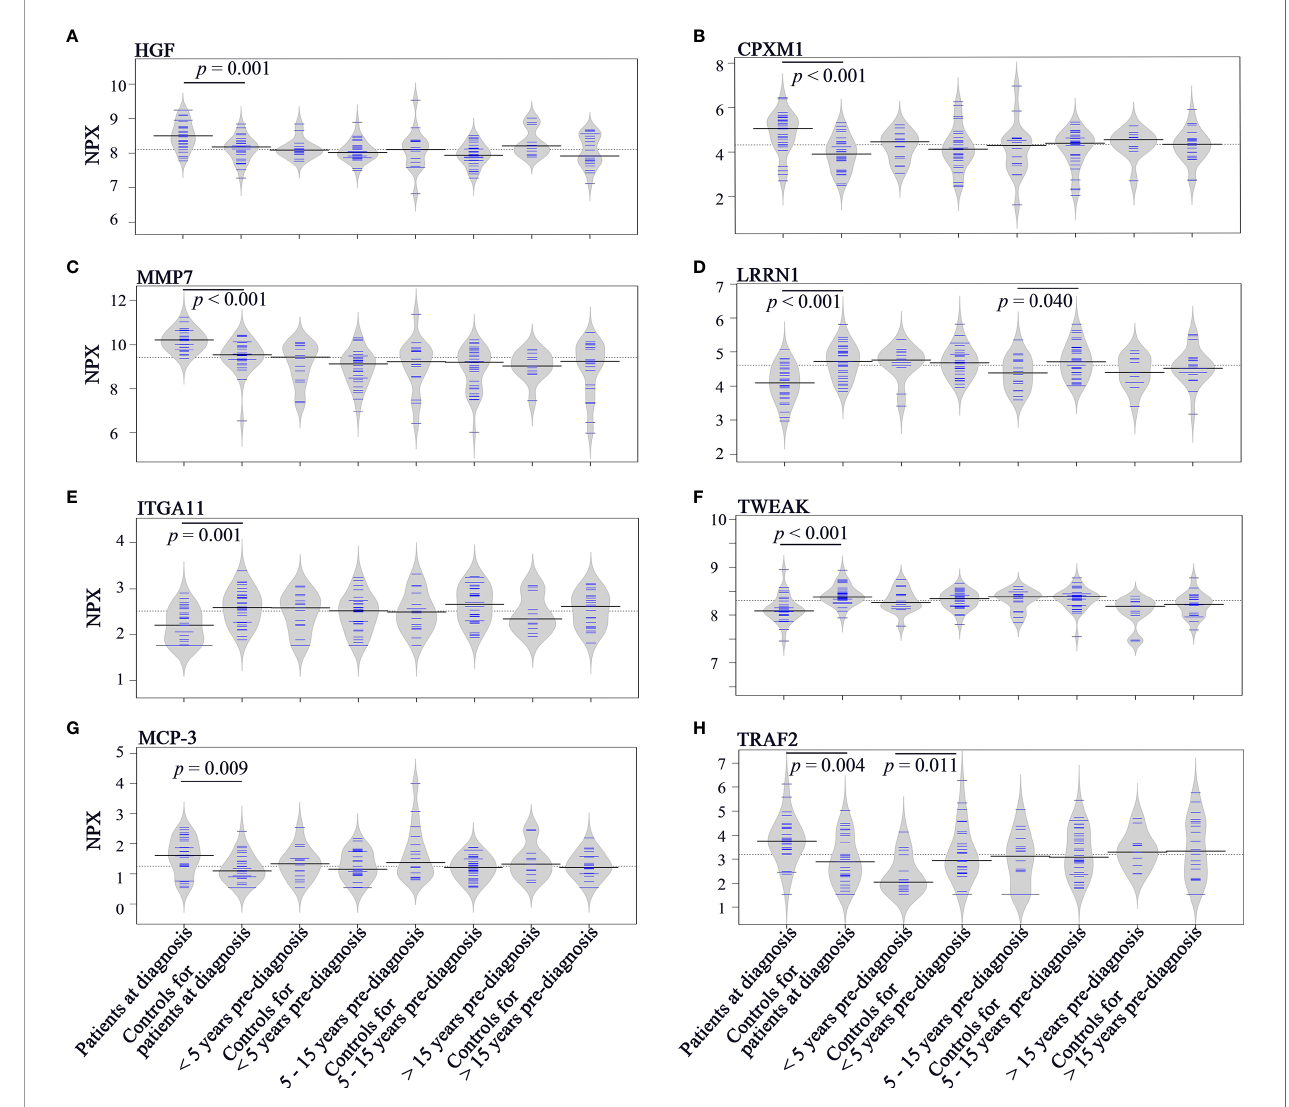
FIGURE 4 | Bean plots showing protein levels in different groups of plasma samples. (A) HGF. (B) CPXM1. (C) MMP7. (D) LRRN1. (E) ITGA11. (F) TWEAK. (G) MCP-3. (H) TRAF2. The grey area shows the estimated density of distribution. The horizontal lines within the grey area show individual observations, while the black line is the